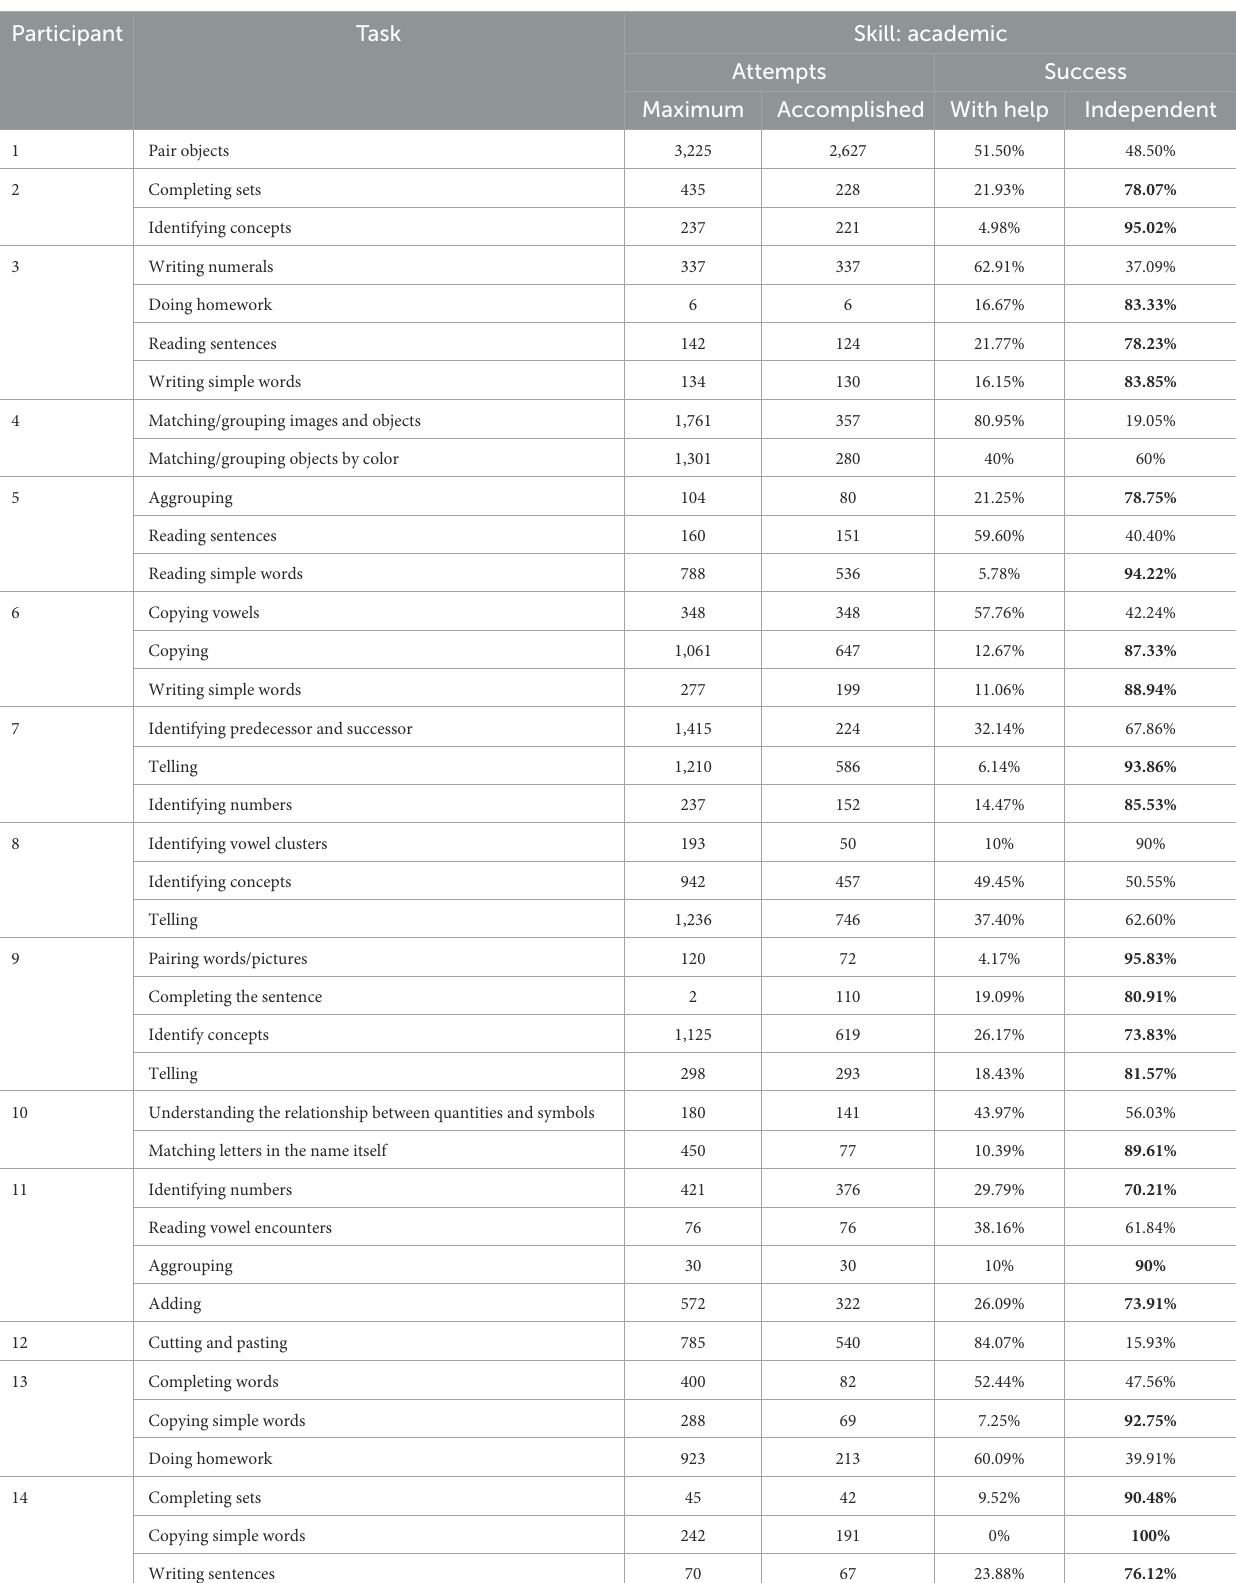
TABLE 3 Participants’ task training results for academic